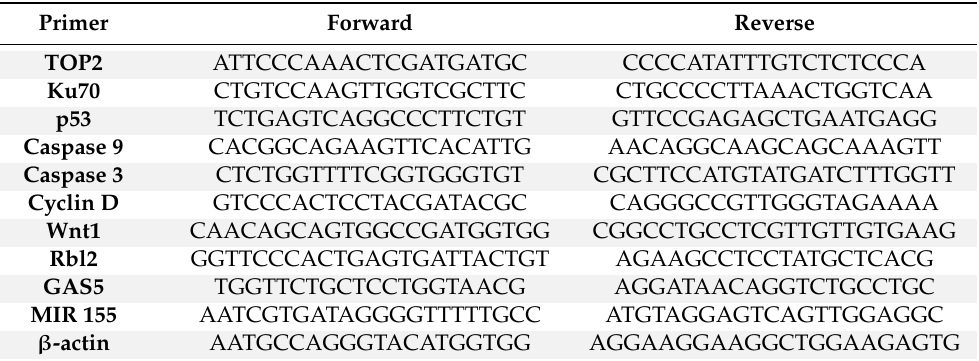
Table 1. Sequences of human